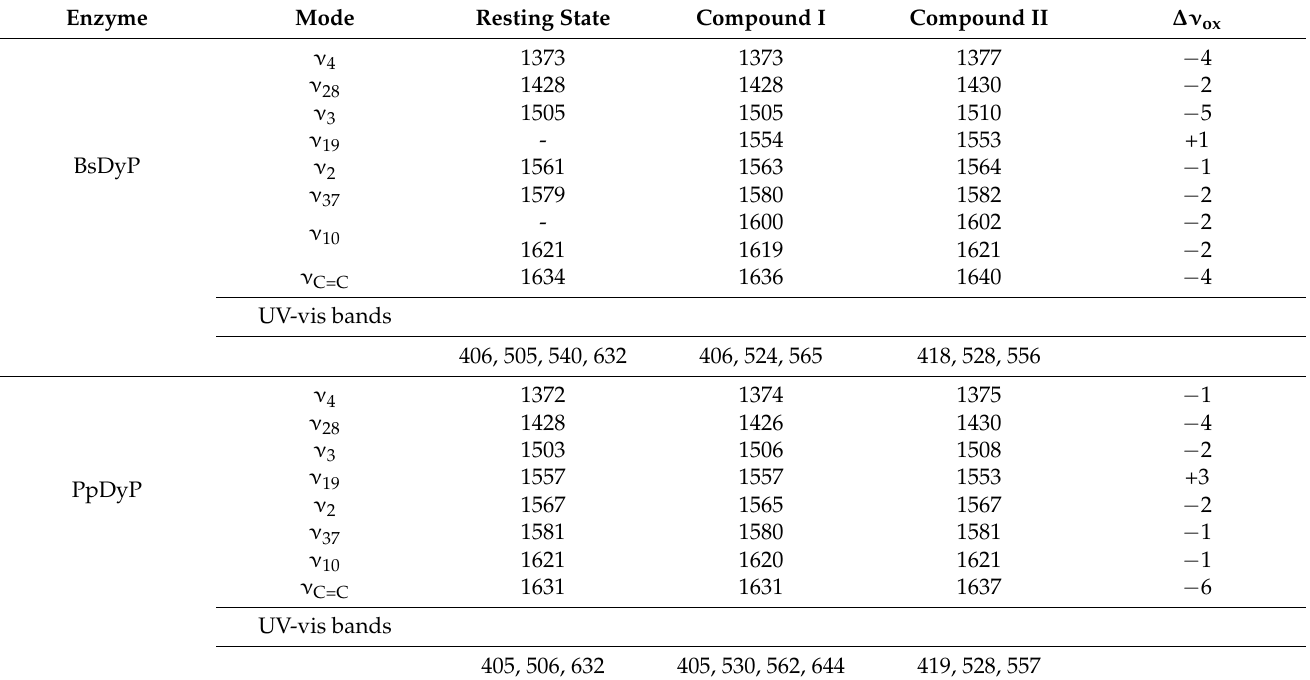
Table 1. Resonance Raman and UV-vis absorption marker bands for the resting state, compound I and compound II of the BsDyP and PpDyP enzymes. RR band positions are expressed in cm − 1 and UV-vis in nm. ∆ ν ox refers to the difference in positions between compound I minus compound